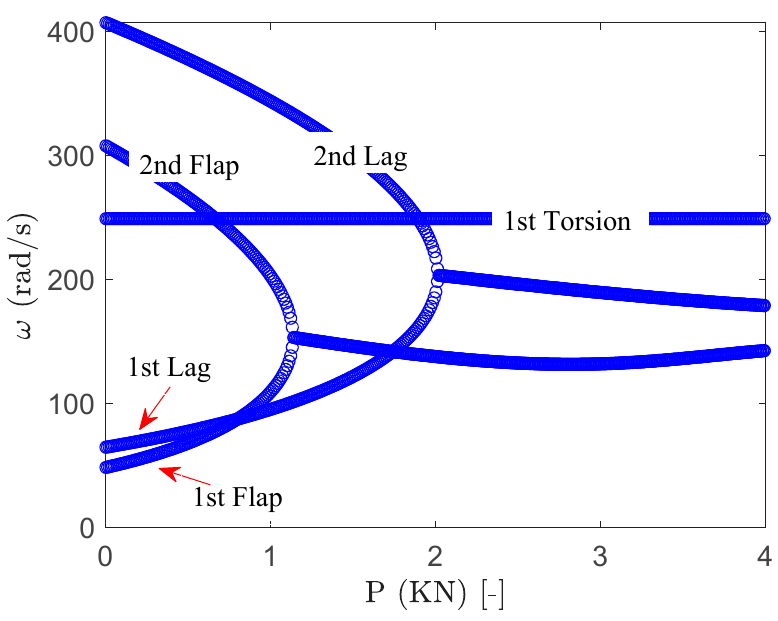
Figure 3. The variation of the first five frequencies of the stationary composite blade subjected to compressive force for θ = 0 ◦ .